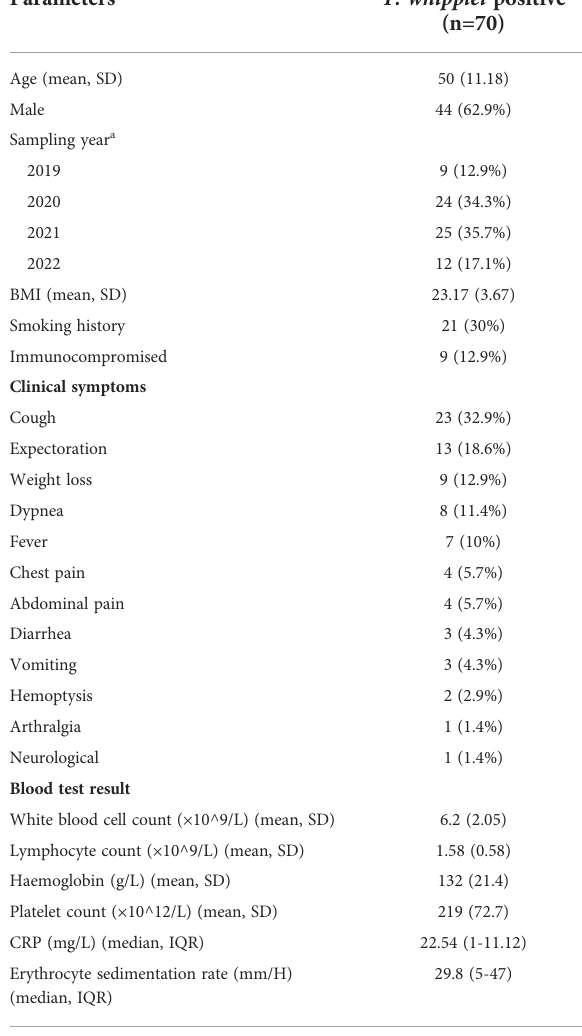
TABLE 1 The characteristics of patients with T. whipplei positive in BALF.